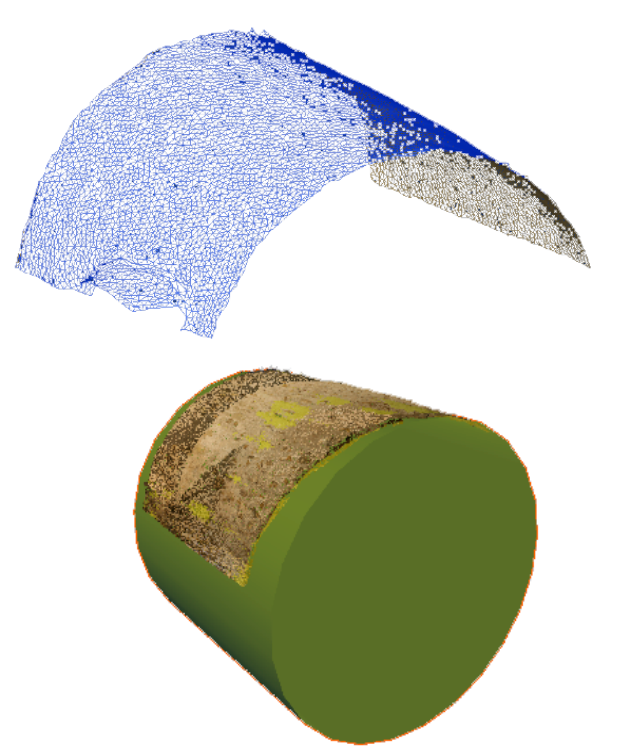
Figure 1: Definition of the primitive for a vault. Up, a mesh from point cloud; down, detection of the cone closest to the